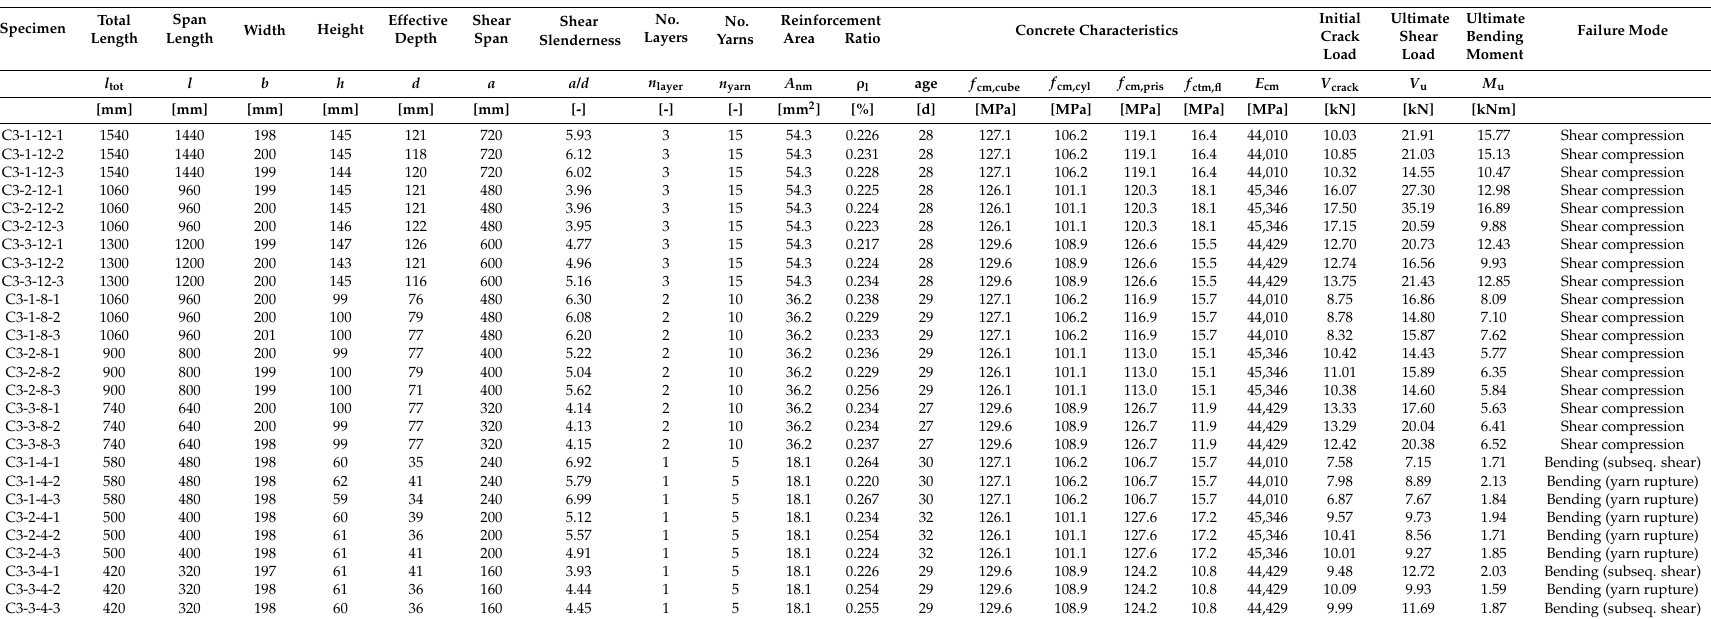
Table 4. Experimental results of shear